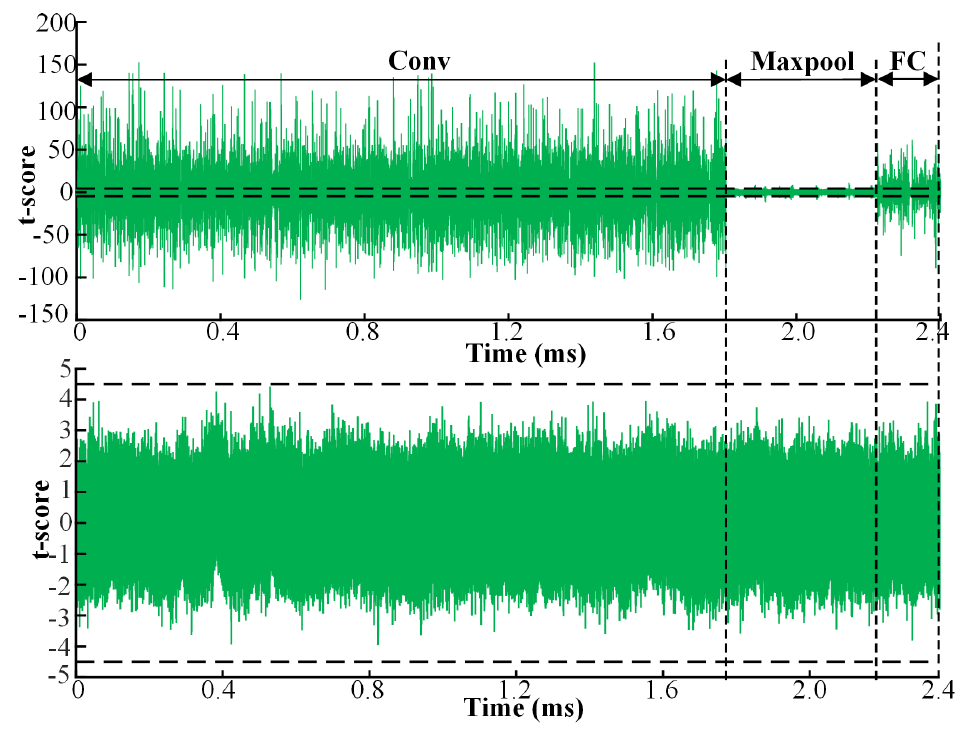
Figure 20: TVLA results of the masked ConvNet hardware with 1M traces. When the PRNGs are off (i.e., the design is effectively unprotected), the design has significant side-channel leakage as expected. However, when the PRNG is on (i.e., the design is masked), there is no first-order leakage, i.e., empirical results match our theoretical proofs of